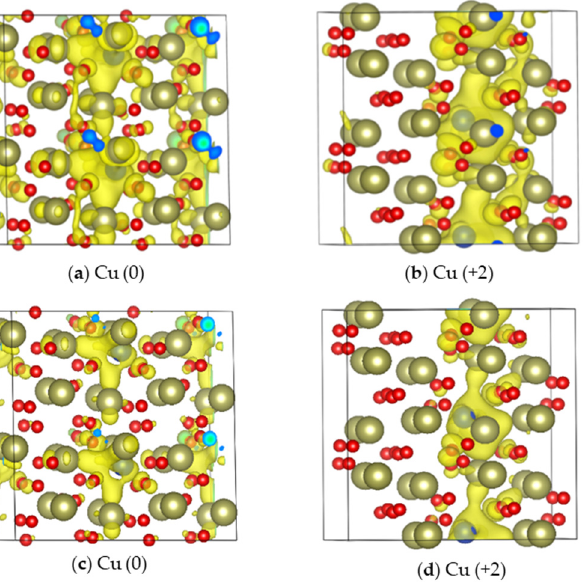
Figure 3. Isosurface plot of the partial charge density of the ( a ) Cu (0) and ( b ) Cu (+2) systems (isosurface level = 0.001) and the ( c ) Cu (0) and ( d ) Cu (+2) systems (isosurface level = 0.0025) (Red balls are O, brown balls are Cu, and Cu atoms are wrapped in yellow).